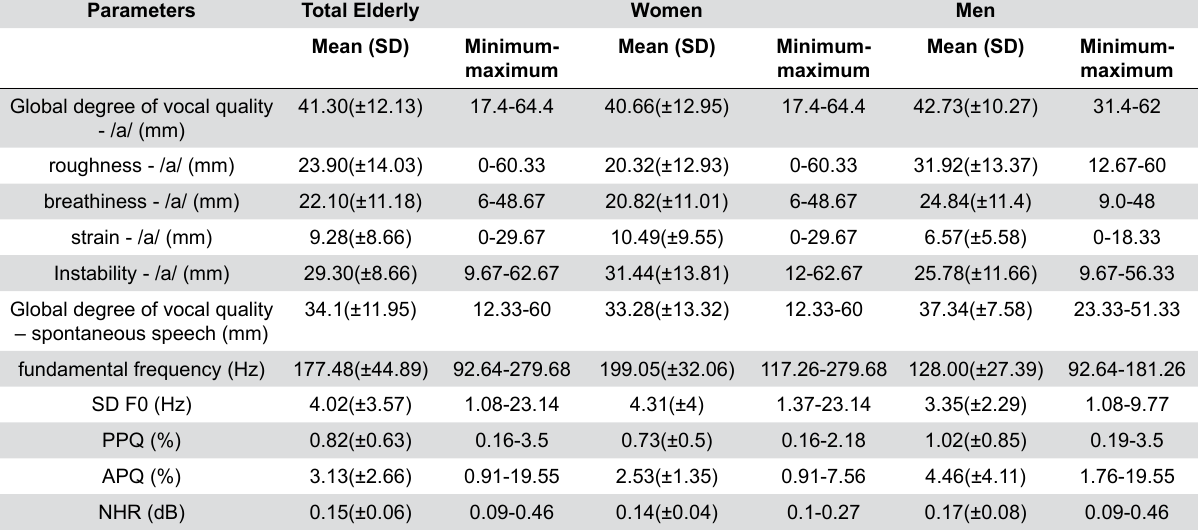
Table 2- Values of parameters of the perceptual analyze and acoustic parameters of men and women Parameters